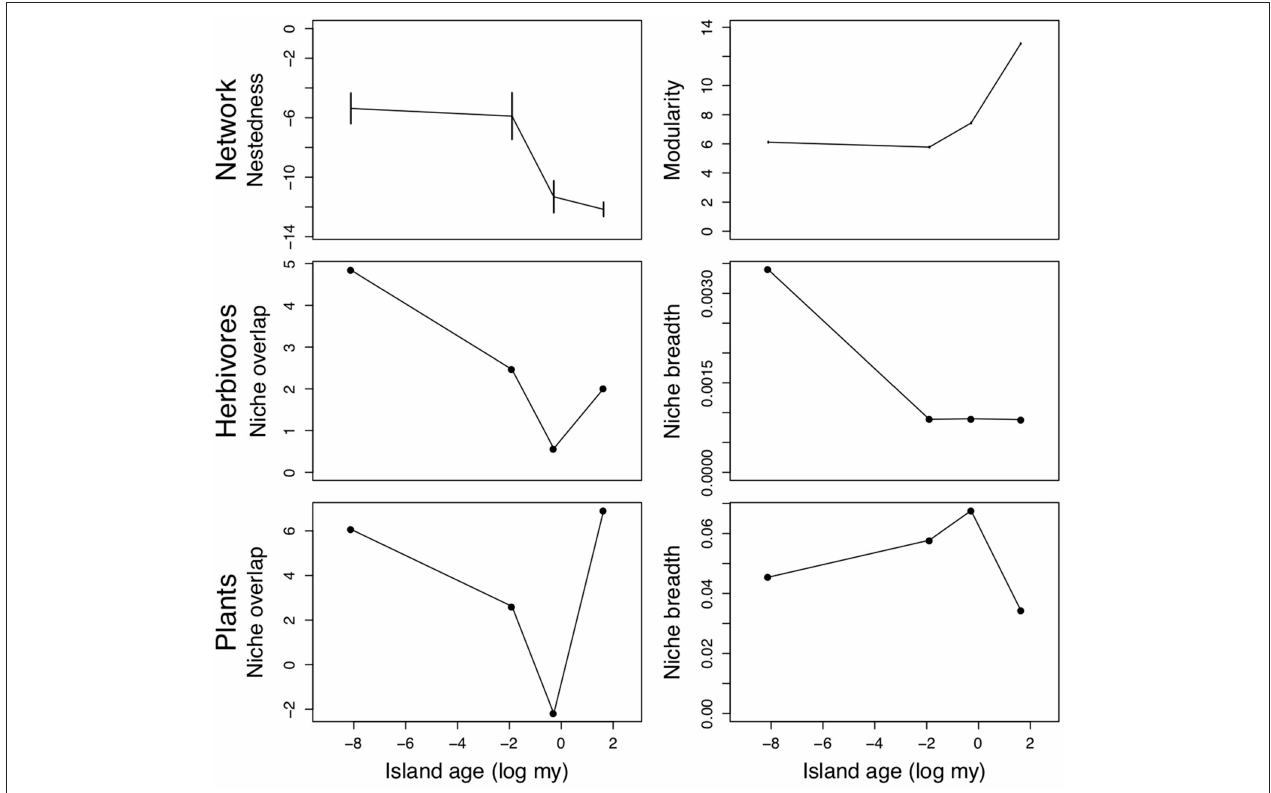
FIGURE 4 | Network nestedness and modularity ( z -scores, Top panels), niche overlap and average niche breadth of herbivores (Middle panels) and plants (Bottom panels) along the Hawaiian chronosequence (from youngest to oldest: Kilauea, Hawaii; Kohala, Hawaii; Haleakala, Maui; Kokee, Kauai). Error bars for nestedness and modularity represent the 95 % confidence intervals generated by the null community simulation.